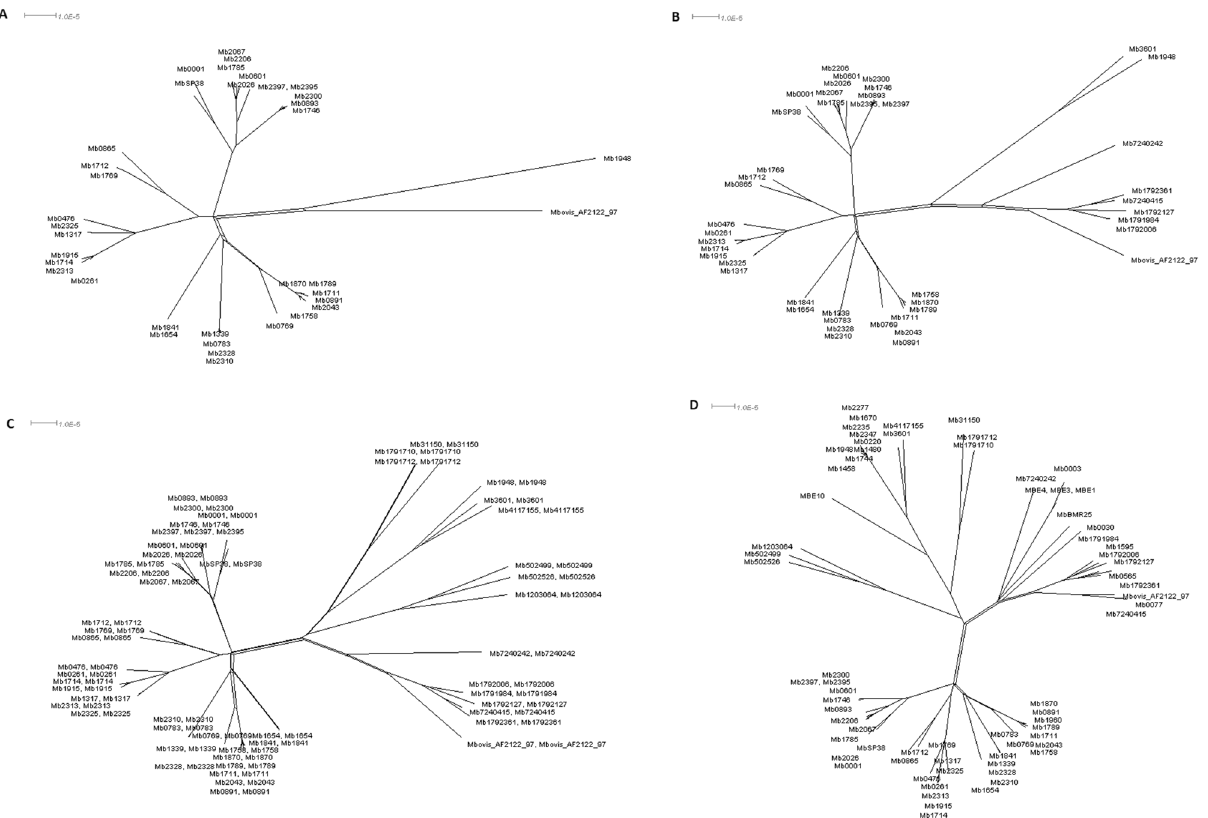
Figure 3. Visualization of conflicting phylogenetic signals at unrooted phylogenetic trees by the split decomposition method in European 2 genomes ( n = 37) ( A ), in European genomes ( n = 44) ( B ), in a combination of European and African genomes ( n = 51) ( C ) and in the entire dataset ( n = 70) (D).